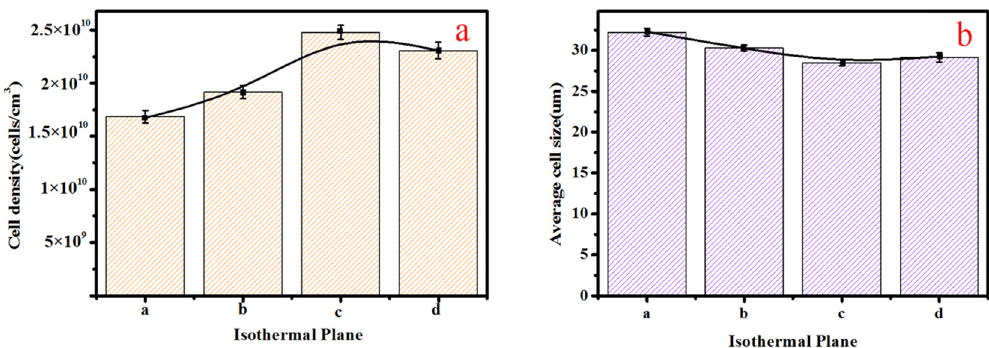
Figure 14: Structural parameters of the cells in di ff erent regions of the same isothermal plane for the PP foam: ( a ) cells density and ( b ) average cell